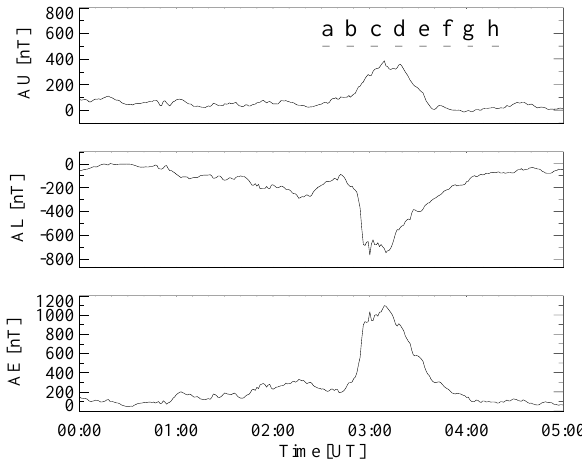
Fig. 1. The AE , AL and AU -indices of 31 July 1997. The letters a–h correspond to the time periods when we have measurements from PIXIE and